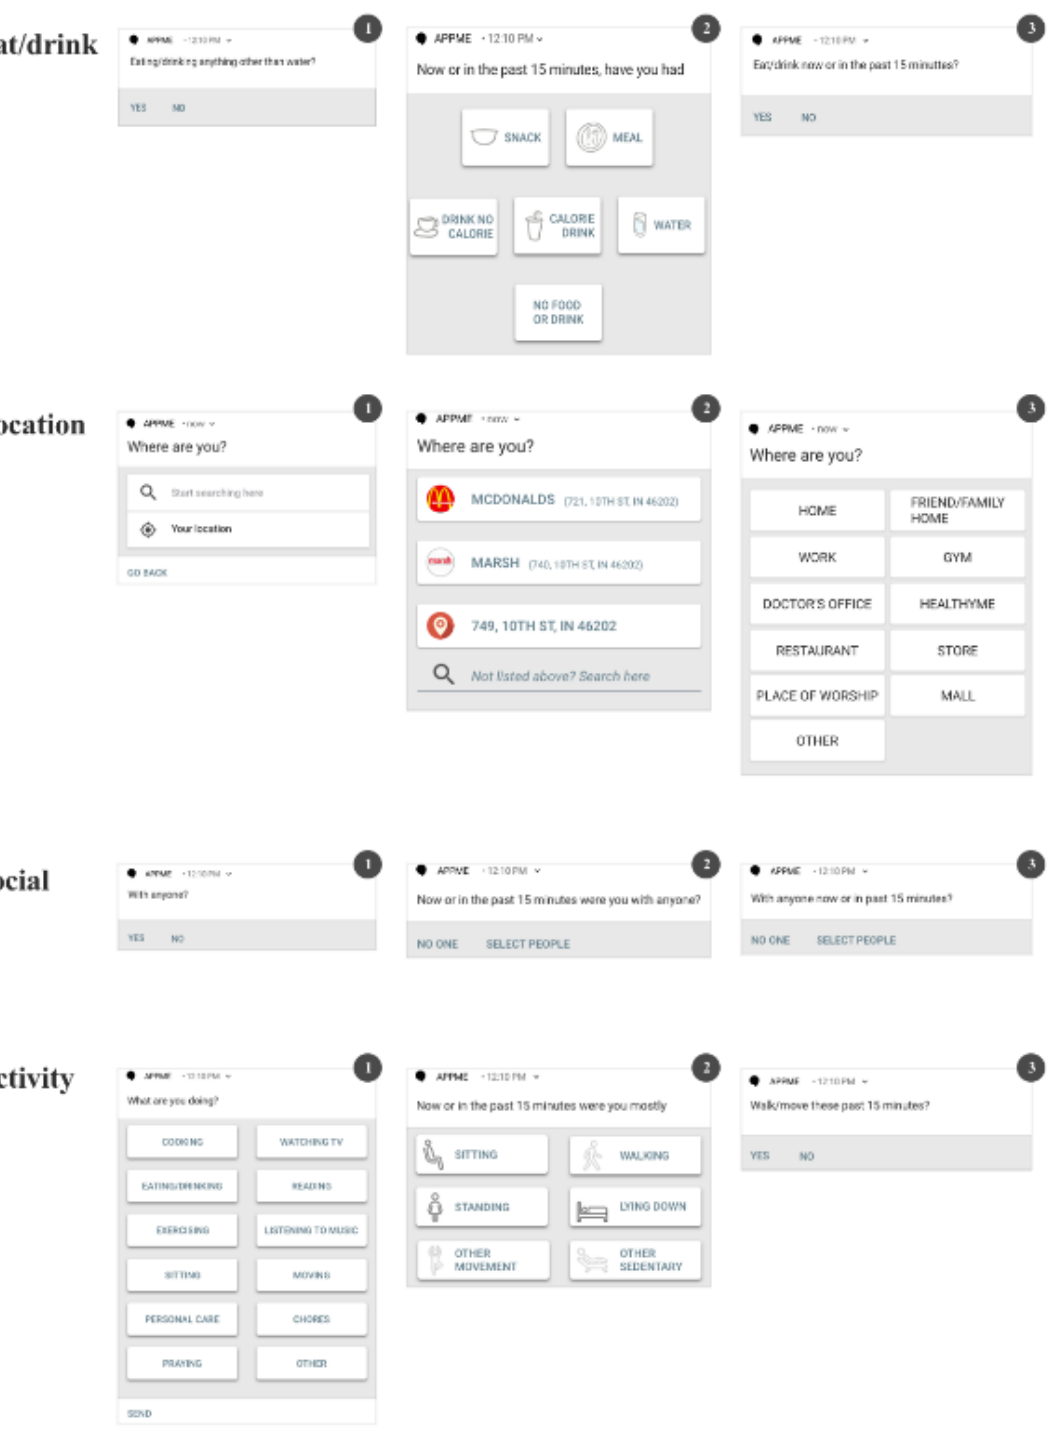
Figure 1. Three versions of ecological momentary assessment questions resulting from iterative design